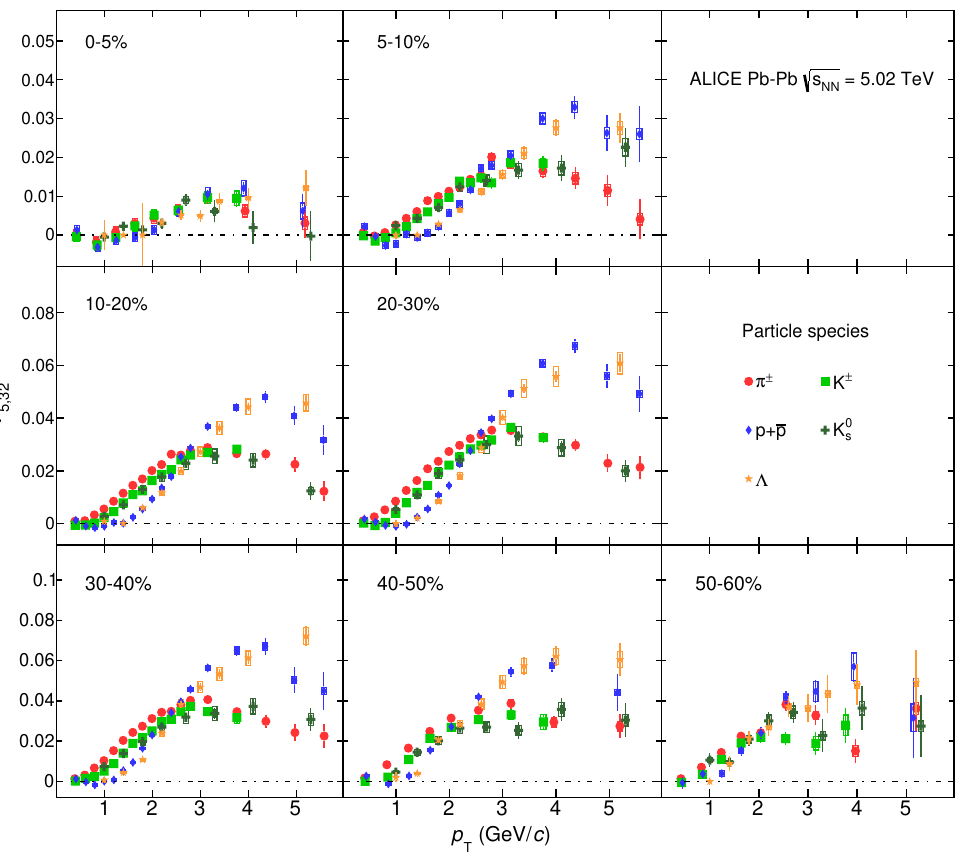
Figure 7 . The p T -di(cid:11)erential v 5 ; 32 for di(cid:11)erent particle species grouped into di(cid:11)erent centrality p intervals of Pb-Pb collisions at s NN = 5 : 02 TeV. Statistical and systematic uncertainties are shown as bars and boxes,